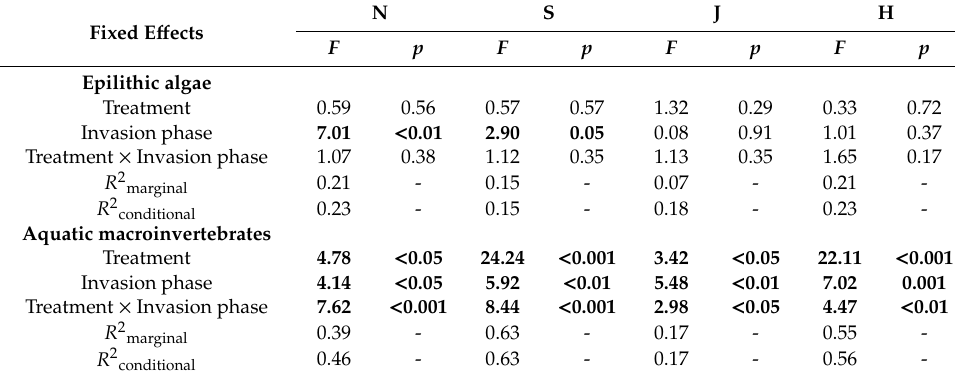
Table 2. Summary of ANOVA type III for responses fitted with linear mixed-e ff ects models. F values are represented with p -values on the basis of Kenward–Roger approximations for df (degrees of freedom). Significant di ff erences ( p < 0.05) are highlighted in bold. N = relative taxa abundance; S = taxa richness; J = Pielou’s evenness; H = Shannon–Weaver diversity index. Variance explained by each model is given by marginal R 2 for the fixed e ff ects only and conditional R 2 for fixed and random e ff